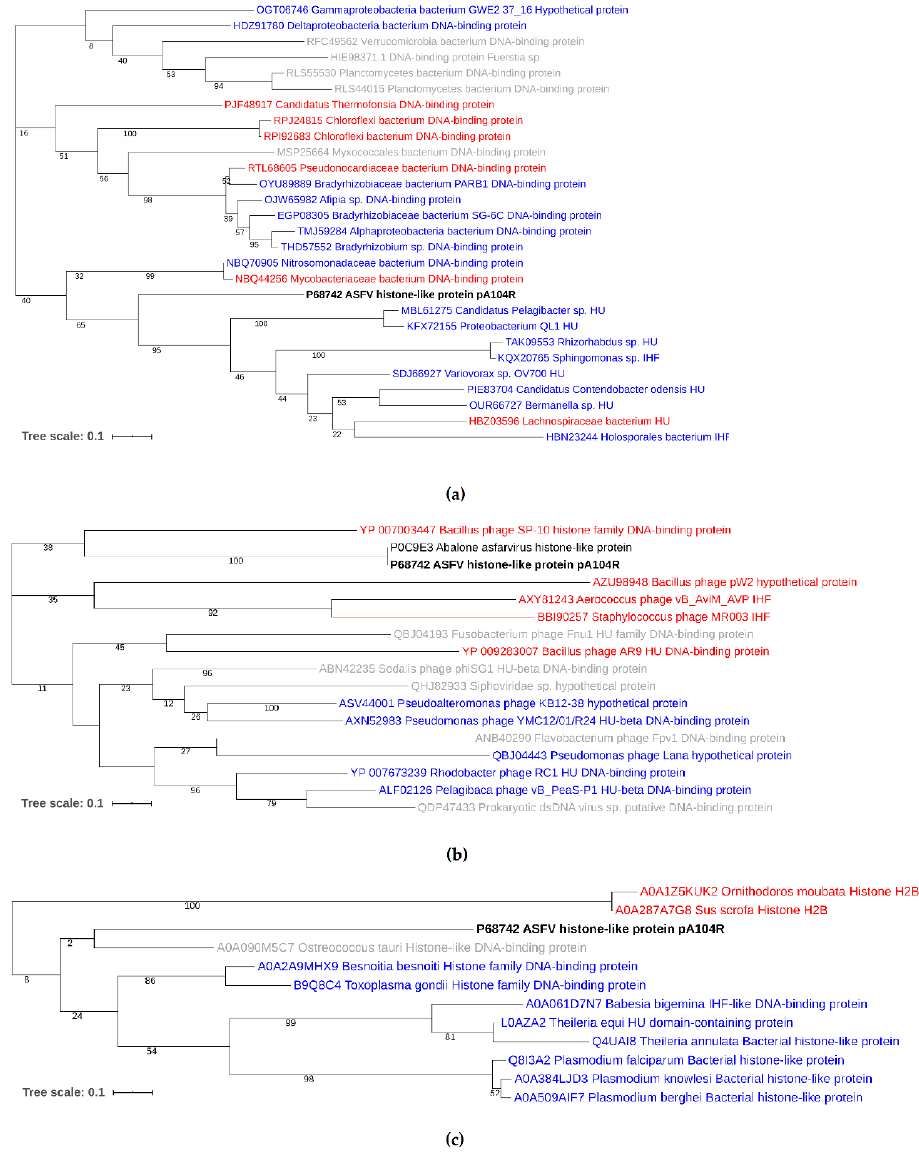
Figure 2. Phylogenetic analysis of pA104R: ( a ) Phylogenetic tree of DNABII bacterial sequences. Blue labels represent Proteobacteria sequences. Red labels represent Terrabacteria group sequences. Grey labels represent other bacterial sequences; ( b ) Phylogenetic tree of DNABII viral sequences. Blue labels represent sequences whose host species belong to the Proteobacteria phylum. Red labels represent sequences whose host species belong to the Terrabacteria group; ( c ) Phylogenetic tree of DNABII eukaryotic sequences. Blue labels represent organisms of the phylum Apicomplexa. Sus scrofa and Ornithodoros moubata histones H2B were chosen as an outgroup (red). A BLAST (version 2.10.0) search of the nonredundant protein database was performed using BLOSUM62 matrix and default settings (Expectation value 10, Low complexity filtering, Max No. of answers 25, Word size 3). Sequences having scores > 45, E value < 0.1, and > 25% identity were selected. Trees were generated by MEGA X (version 10.1.8) [75] using the Maximum Likelihood method and Tamura-Nei model [76] and iTOL (version 4) [77] from a multiple sequence alignment of the relevant sequences generated by MAFFT (version 7) online service using the default settings as described in [78]. The reliability of the tree topology was assessed using Felsenstein’s bootstrap test [79], with 1000 replications. Bootstrap values are shown next to the branches. The scale bars indicate the expected number of amino acid substitutions per site. Accession numbers are indicated in the